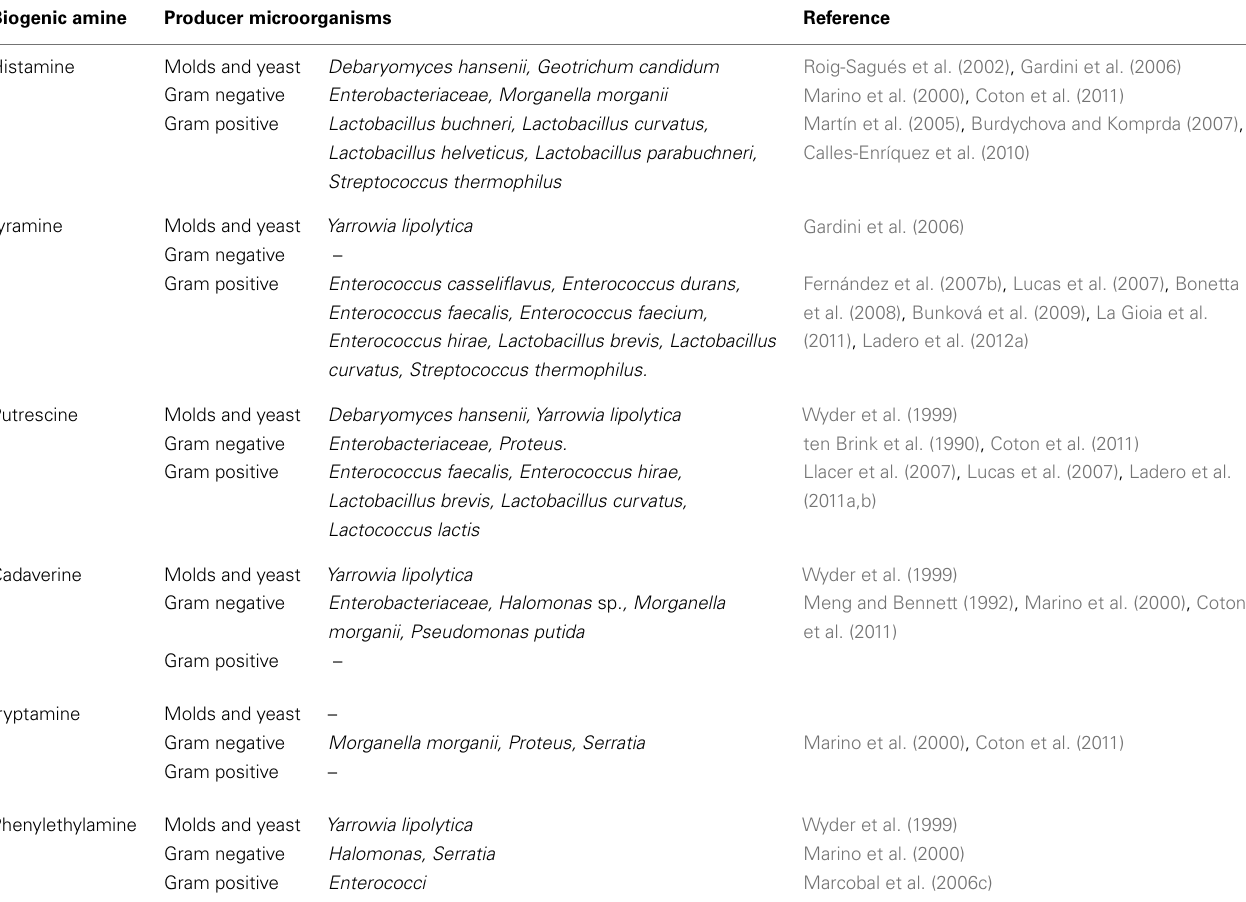
Table 2 | BA-producing microorganisms from dairy